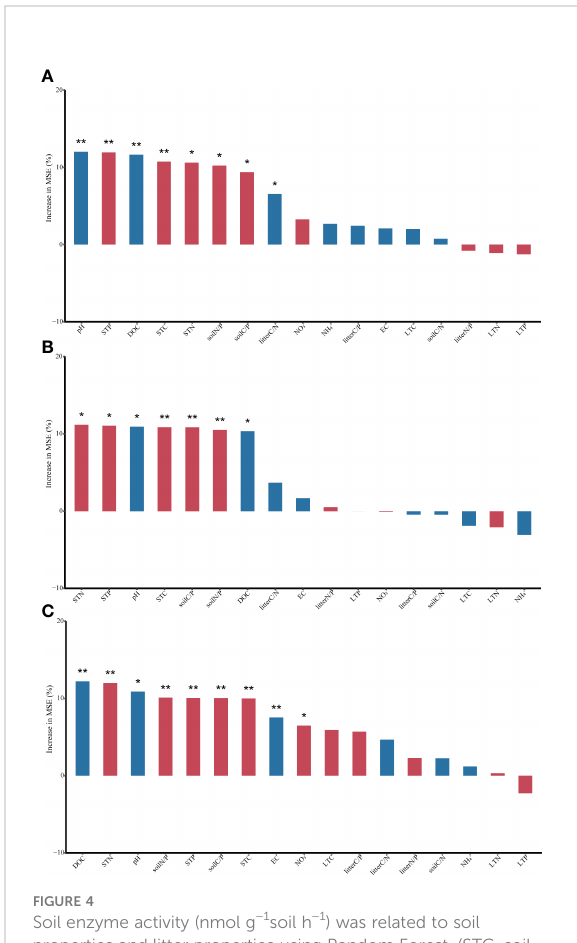
FIGURE 4 Soil enzyme activity (nmol g − 1 soil h − 1 ) was related to soil properties and litter properties using Random Forest. (STC, soil total carbon; STN, soil total nitrogen; STP, soil total phosphorus; LTC, litter total carbon; LTN, litter total nitrogen; LTP, litter total phosphorus. (A) C-acquiring enzyme activity; (B) N-acquiring enzyme activity; (C) P-acquiring enzyme activity. Red columns, a positive correlation; blue columns, a negative correlation. *P < 0.05; **P <